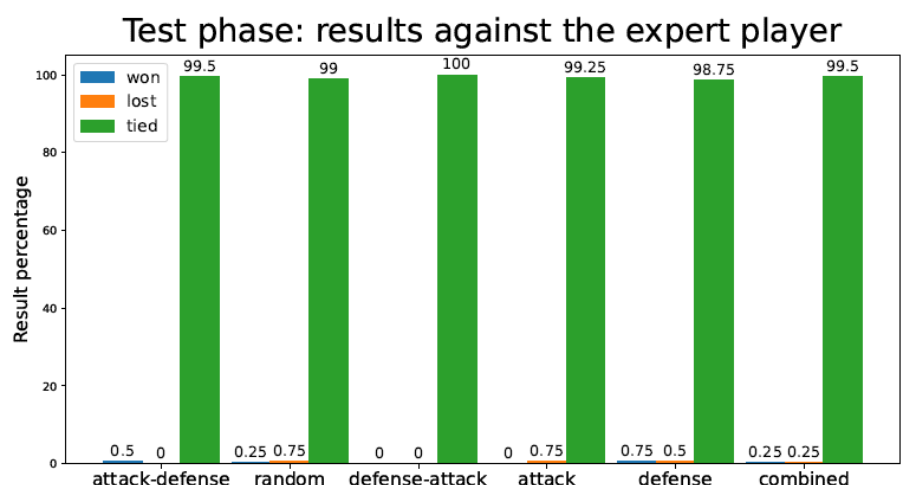
Figure 14. Percentage of test games won/lost/tied by the Connect-4 TD agent playing against an expert player for the different training strategies.